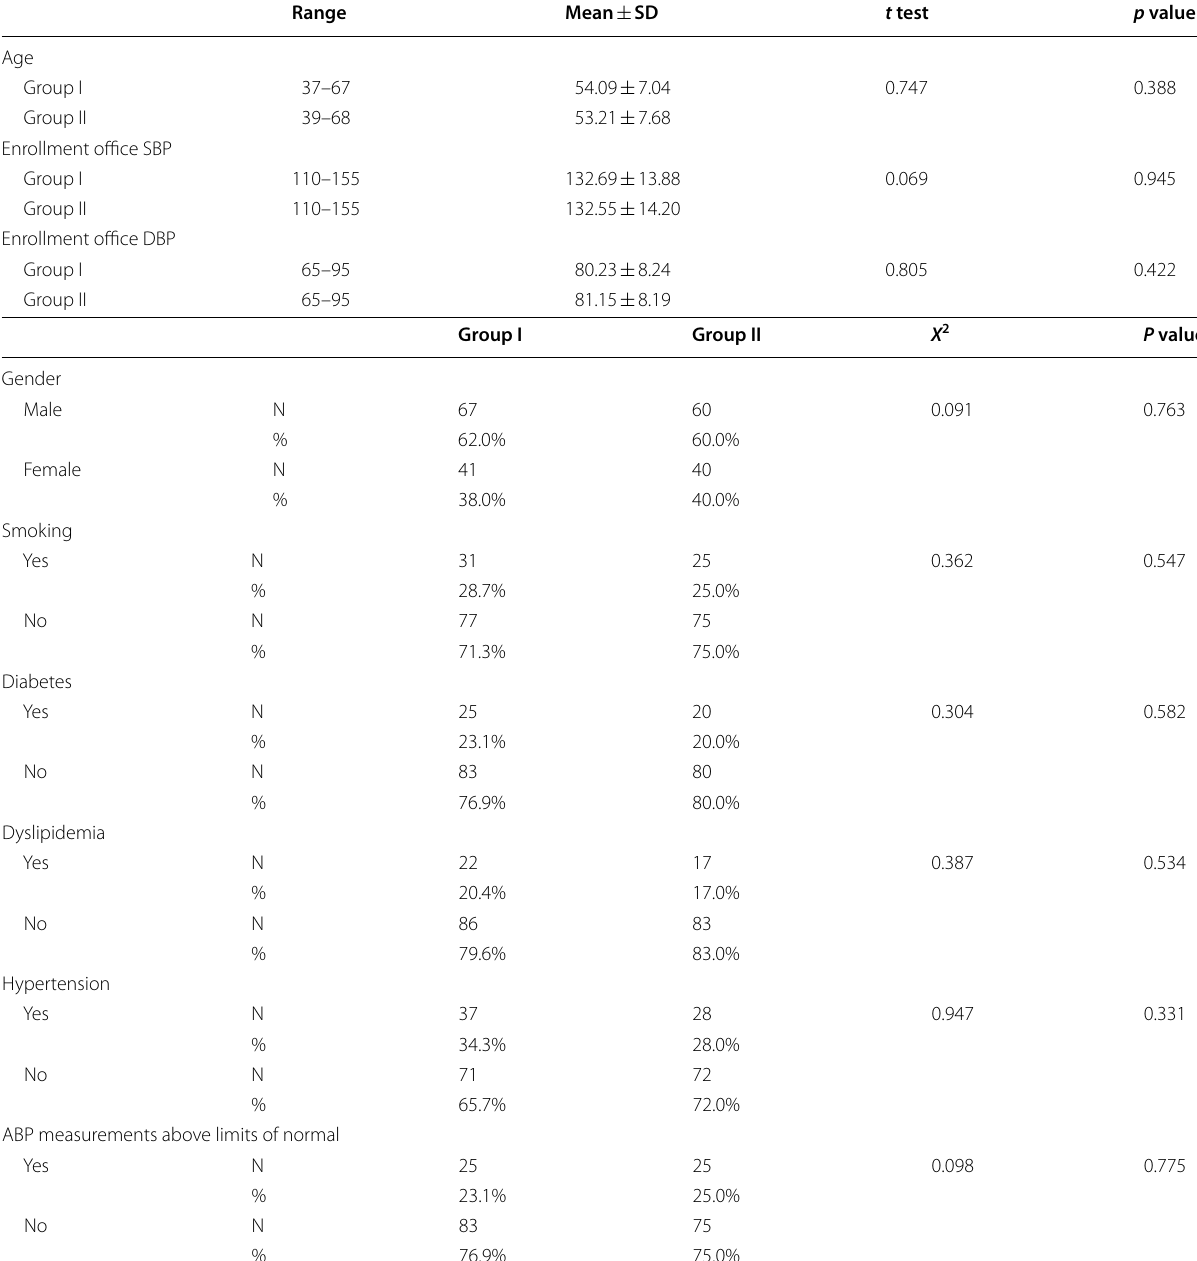
Table 1 Comparing demographic characteristics of the study